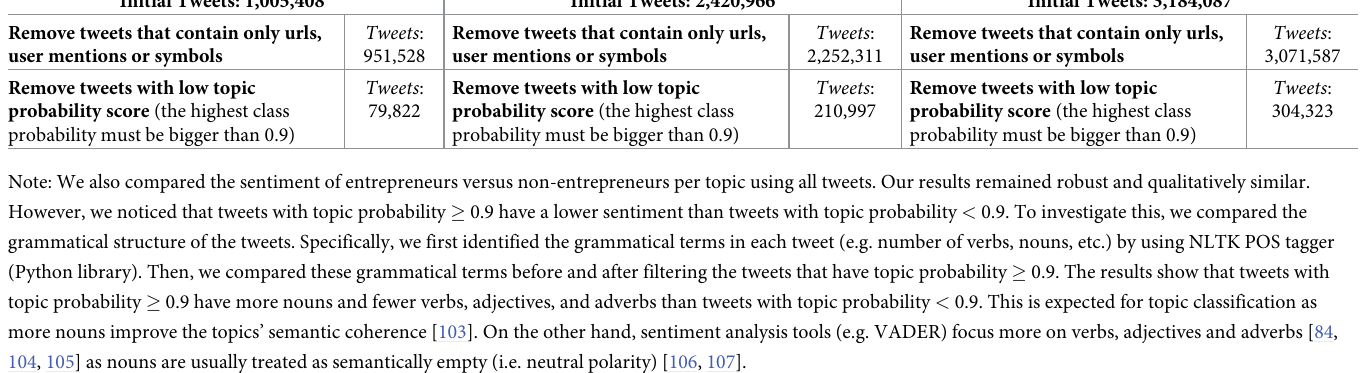
Table 5 column 5 reports our results for social entrepreneurs (research question 2—RQ2)